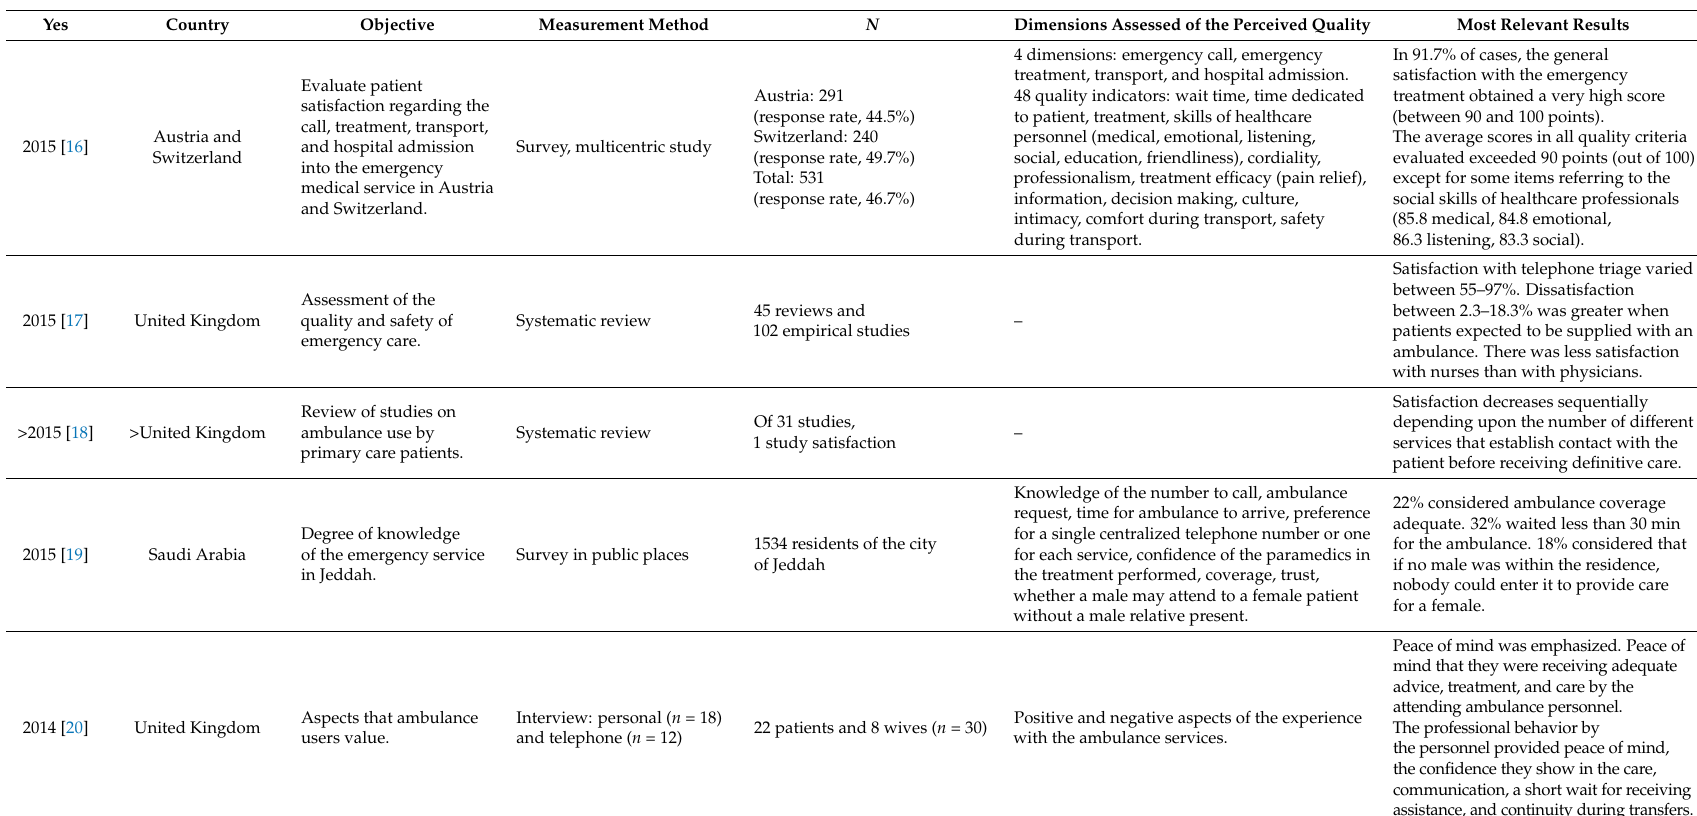
Table 1. Description of studies included in final